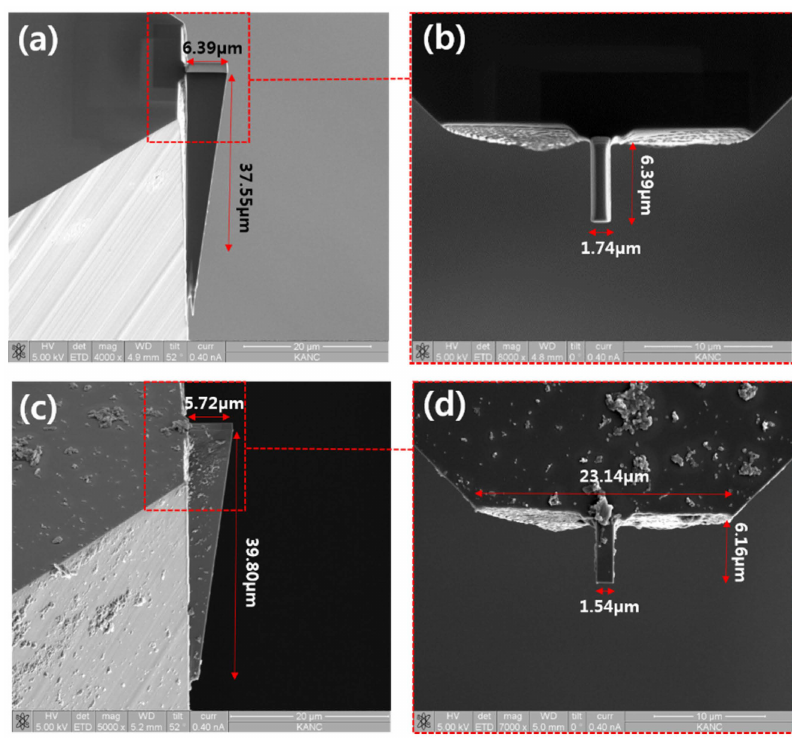
Figure 5. SEM images of 1.5 µ m level FIB machined diamond cutting tool ( a , b ) before removing Pt coating layer; ( c , d ) after removing Pt coating layer using ultra-precision